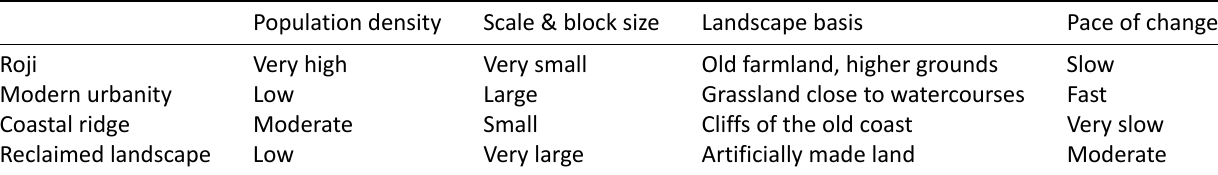
Table 2. Relation between density, scale, landscape and pace of change.